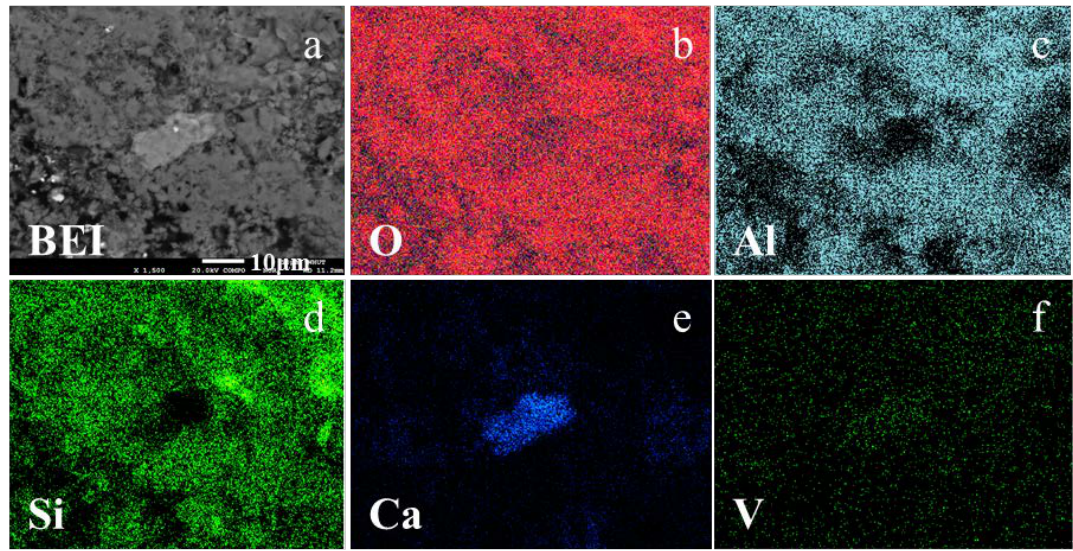
Figure 2. ( a ) BEI of the first type of vanadium-bearing grain in water leaching residue, EDS elemental distribution: ( b ) O, ( c ) Al, ( d ) Si, ( e ) Ca, and ( f ) V.